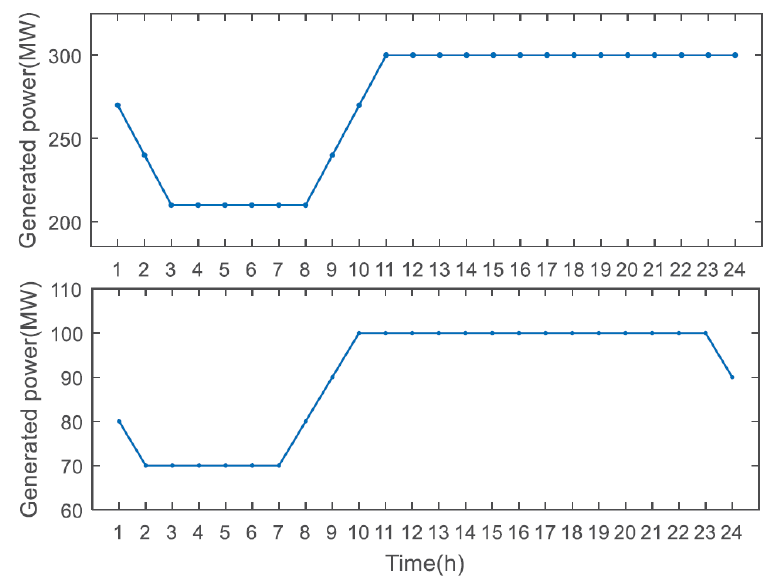
Figure 5. Injected active power of nuclear generation